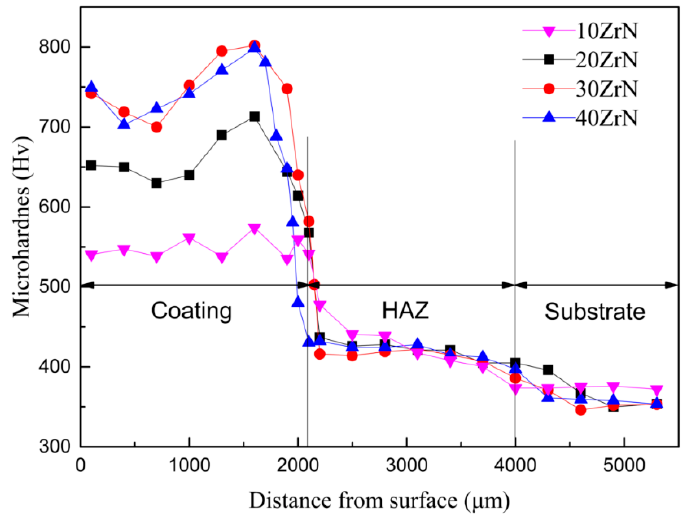
Figure 7. Microhardness of samples with different ZrN additions.